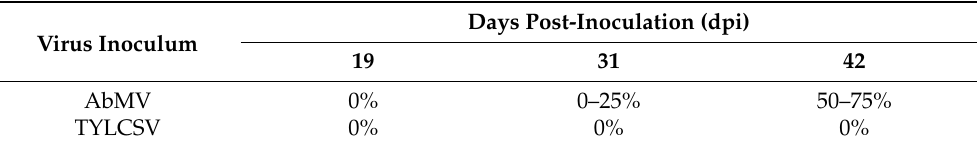
Table 1. Effect of RDR6 depletion on the height of RDR6i Nicotiana benthamiana plants during infection with either AbMV or TYLCSV, compared to wild-type plants. Virus